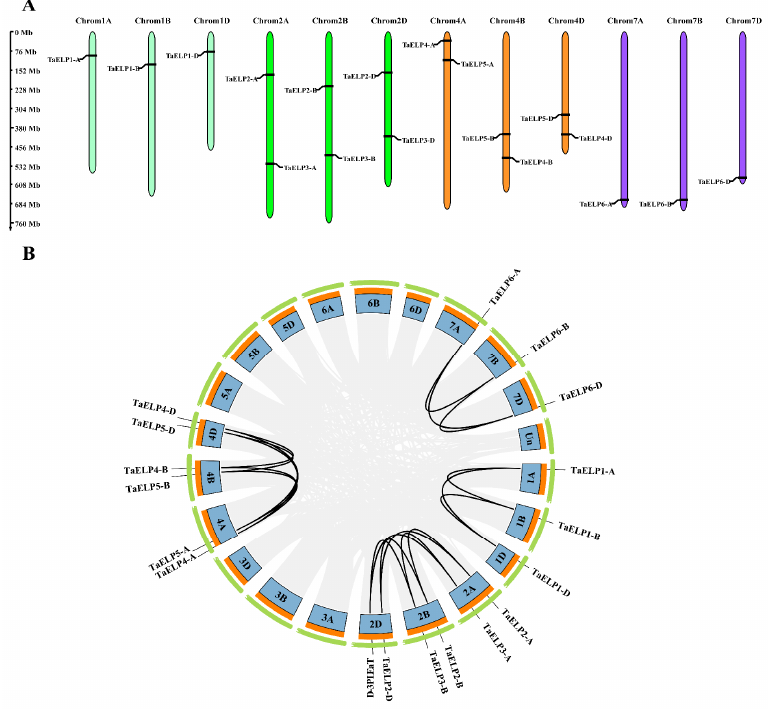
Figure 1. ( A ) Illustration of the chromosomal distribution of TaELPs on wheat chromosomes. The gene name is around the chromosome, and the chromosome numbers of three subgenomes are displayed at the top of each chromosome. ( B ) Genomic localization and replication event analysis of 18 TaELPs genes. Light gray lines in the background indicate syntenic blocks within the bread wheat genome. Duplicate events are highlighted with black